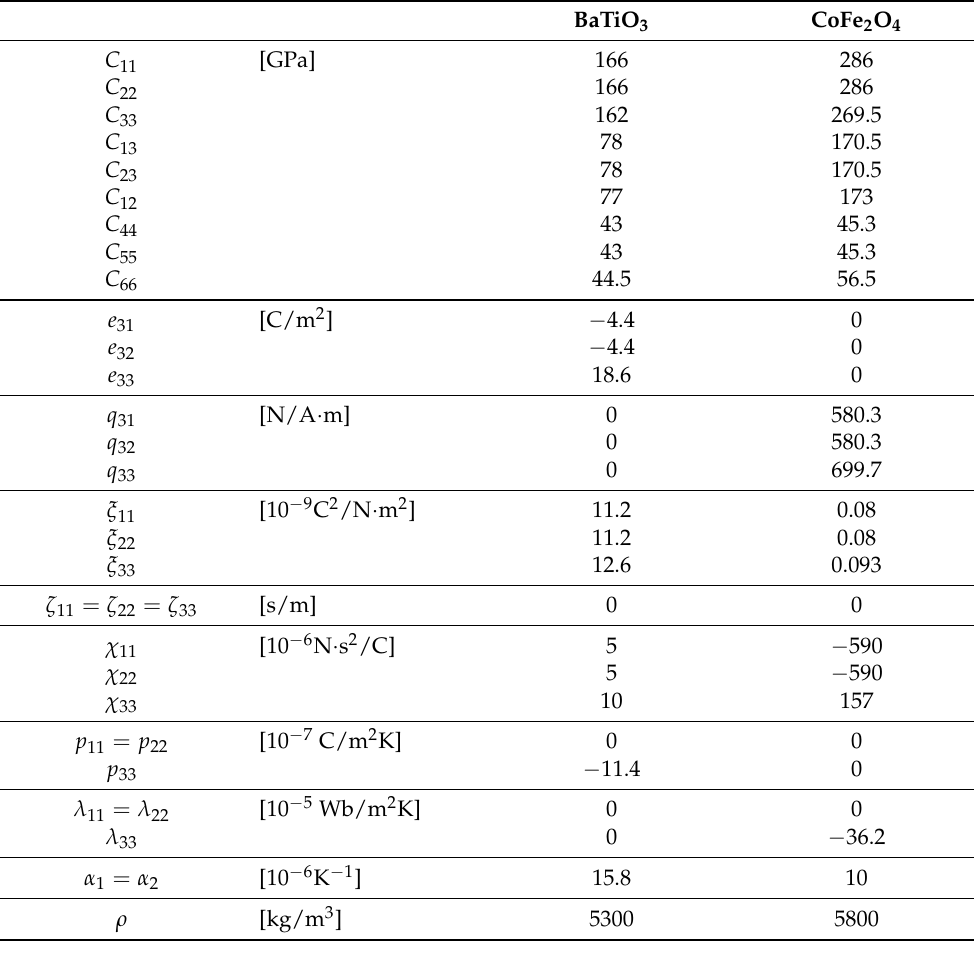
Table 1. Piezo-electro-magnetic-thermal properties of BaTiO 3 and CoFe 2 O 4